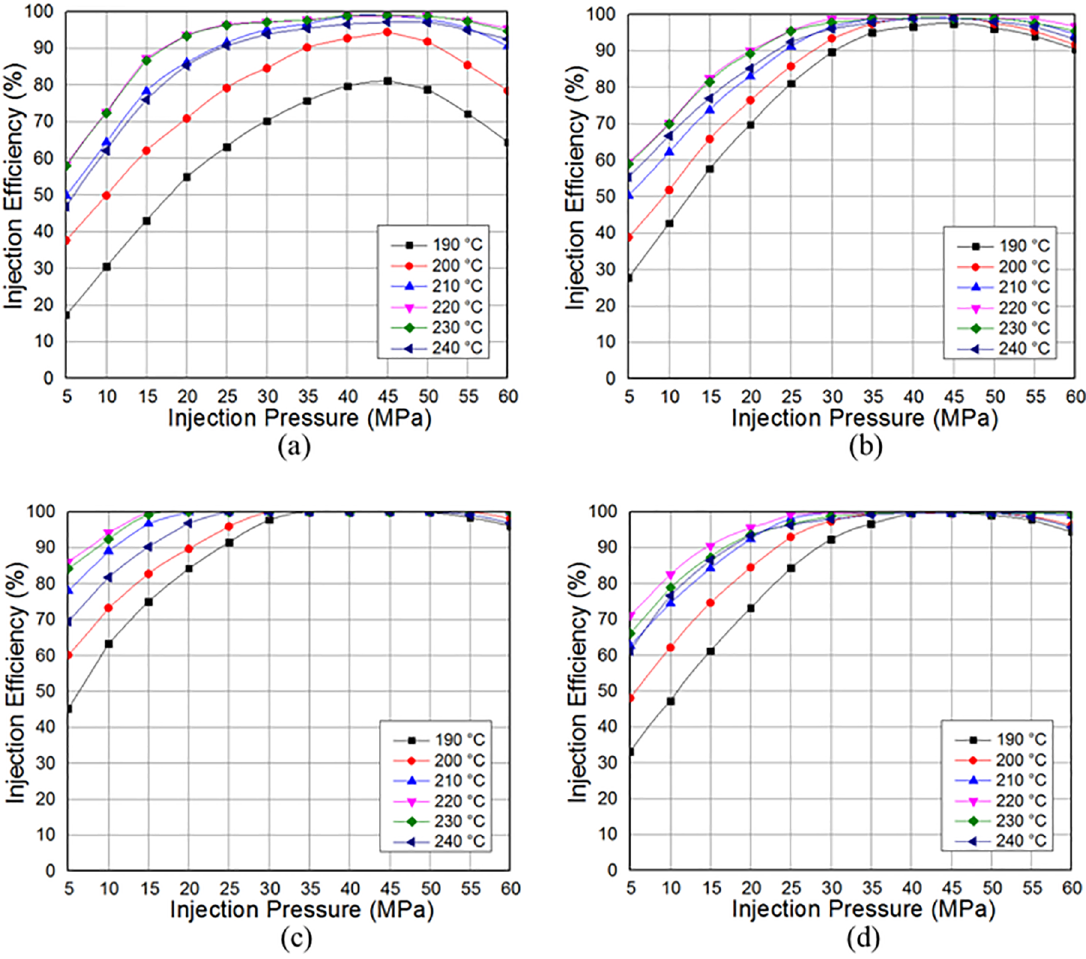
Figure 11. Injection efficiencies obtained with the modified mold (with venting system) varying the injection pressure and temperature for distinct situations of mold temperatures: a) 20 ºC; b) 30 ºC; c) 40 ºC; d) 50 ºC. and 60 MPa regardless the injection temperature. On the other hand, the panel located inside Figure 12.d (mold temperature of 50 ºC) revealed that the best simulation results presented a deviation around